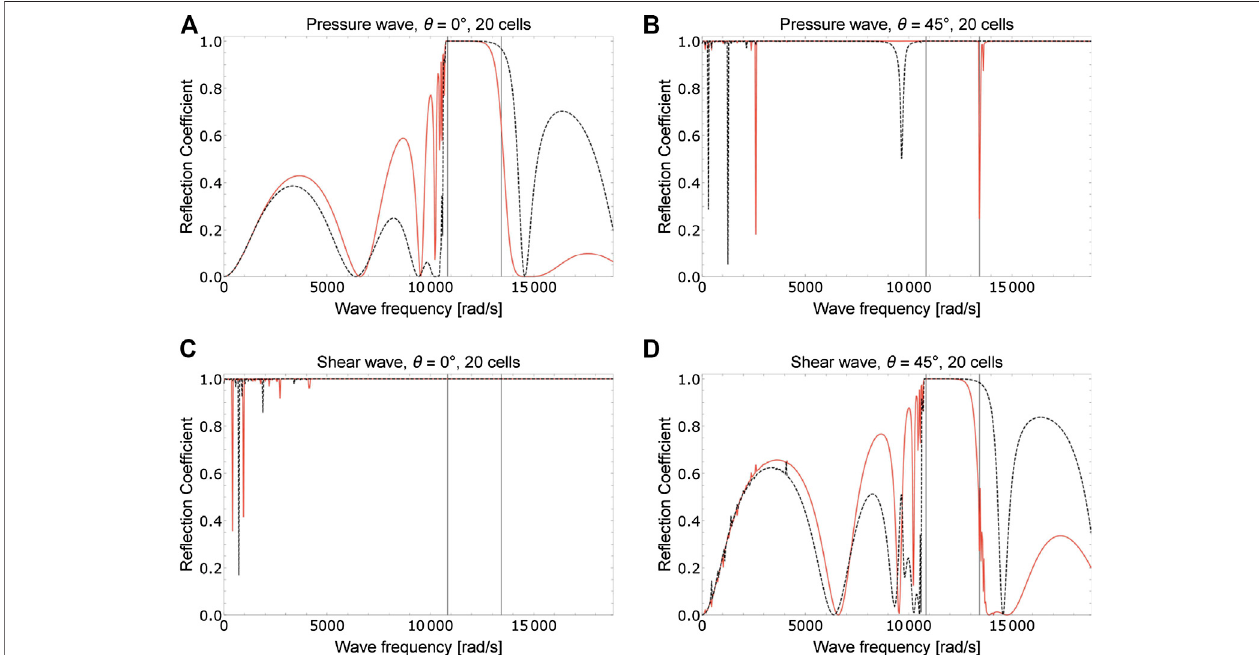
FIGURE 8 | Comparison of the microstructure ’ s (black line) and micromorphic (red line) re fl ection coef fi cient as a function of frequency for a 20 unit cells slab of MM1 and embedded in CM2 . (A) “ pressure ” normal incident wave with respect to the slab ’ s interface. (B) “ pressure ” 45 ° incident wave with respect to the slab ’ s interface. (C) “ shear ” incident wave normal to the slab ’ s interface. (D) “ shear ” 45 ° incident wave with respect to the slab ’ s interface.